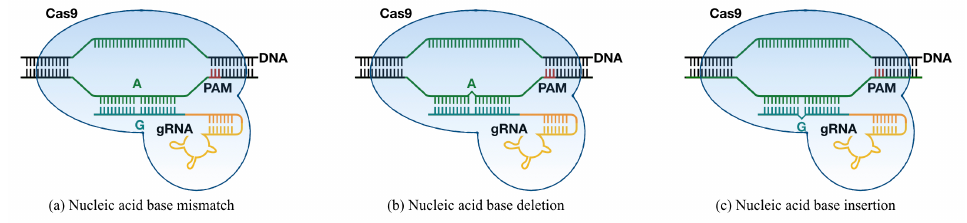
Figure 1. Three categories of off-target activities. ( a ) The situation of base mismatch between guide RNA and target sequence. ( b ) The situation of base deficiency on guide RNA. ( c ) The situation of base insertion on guide